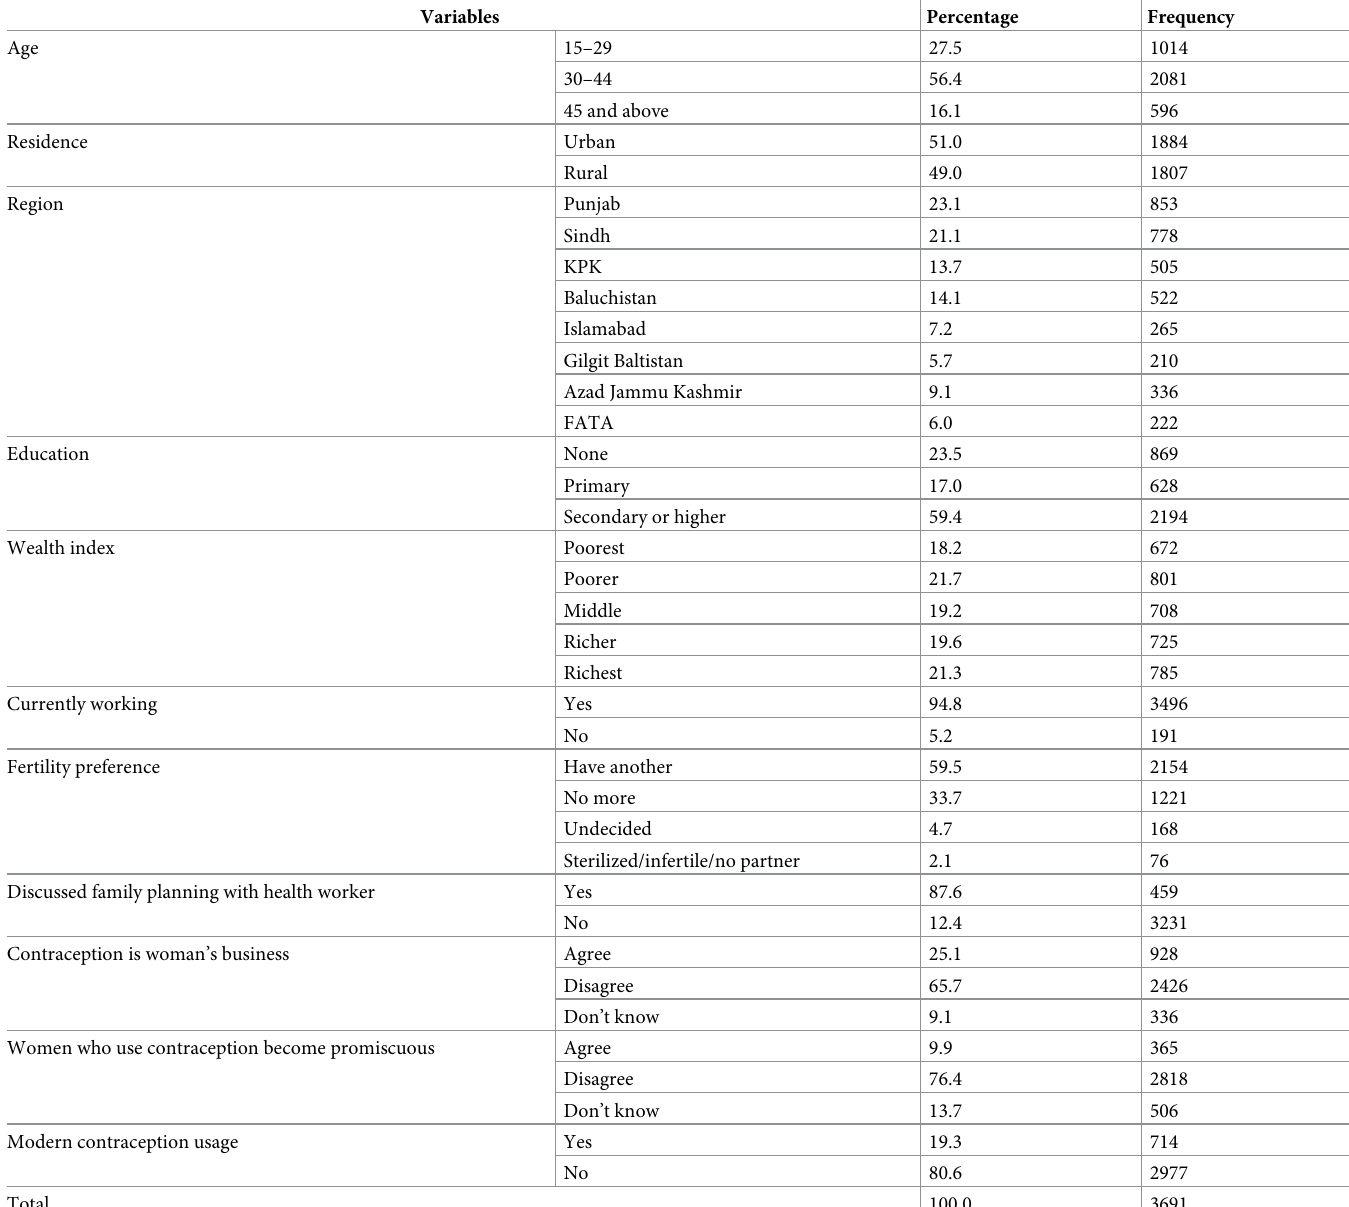
Table 1. Demographic, socioeconomic and behavioral characteristics of